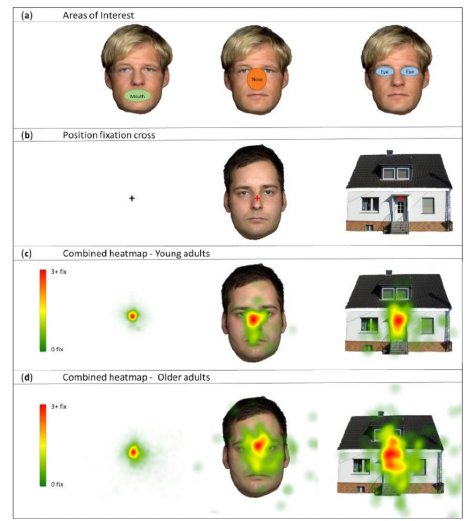
Figure 3. Position and heatmap fixation cross. ( a ) Areas of interest were created within Tobii Studio: mouth, nose, and eyes. ( b ) Red fixation cross illustrates where the fixation cross was positioned relative to the stimuli. ( c ) Group level heatmaps of test stimuli for the young adults group during presentation of 3 conditions: fixation, faces, and houses. ( d ) Group level heatmaps of test stimuli for the older adults group during presentation of 3 conditions: fixation, faces, and